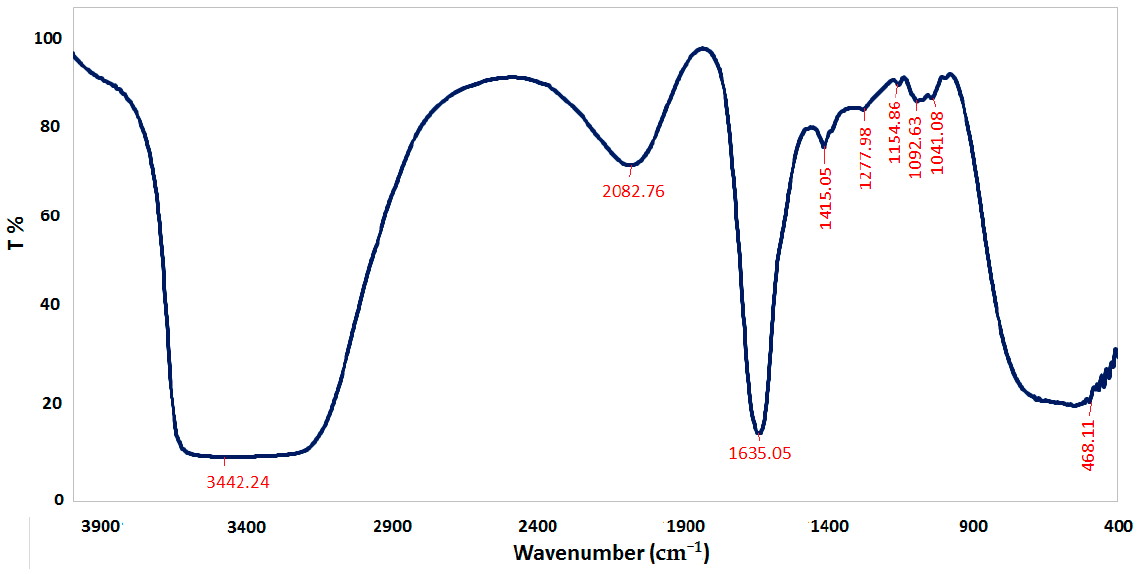
Figure 7. FTIR spectra of A. vera gel incorporated to CSNPs.